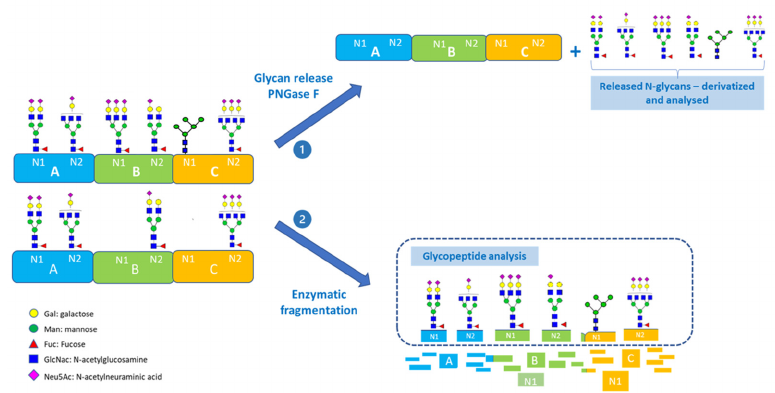
Figure 1. Schematic workflow exemplifying the glycan analysis of a complex glycoprotein with three domains (A, B and C) containing two N-glycosylation sites in each domain. Domains B and C are partially glycosylated at the N1 site. Glycan analysis by (1) glycan release method by PNGase F: the site-specific information is lost; or by (2) glycopeptide mapping: the site-specific information is maintained.